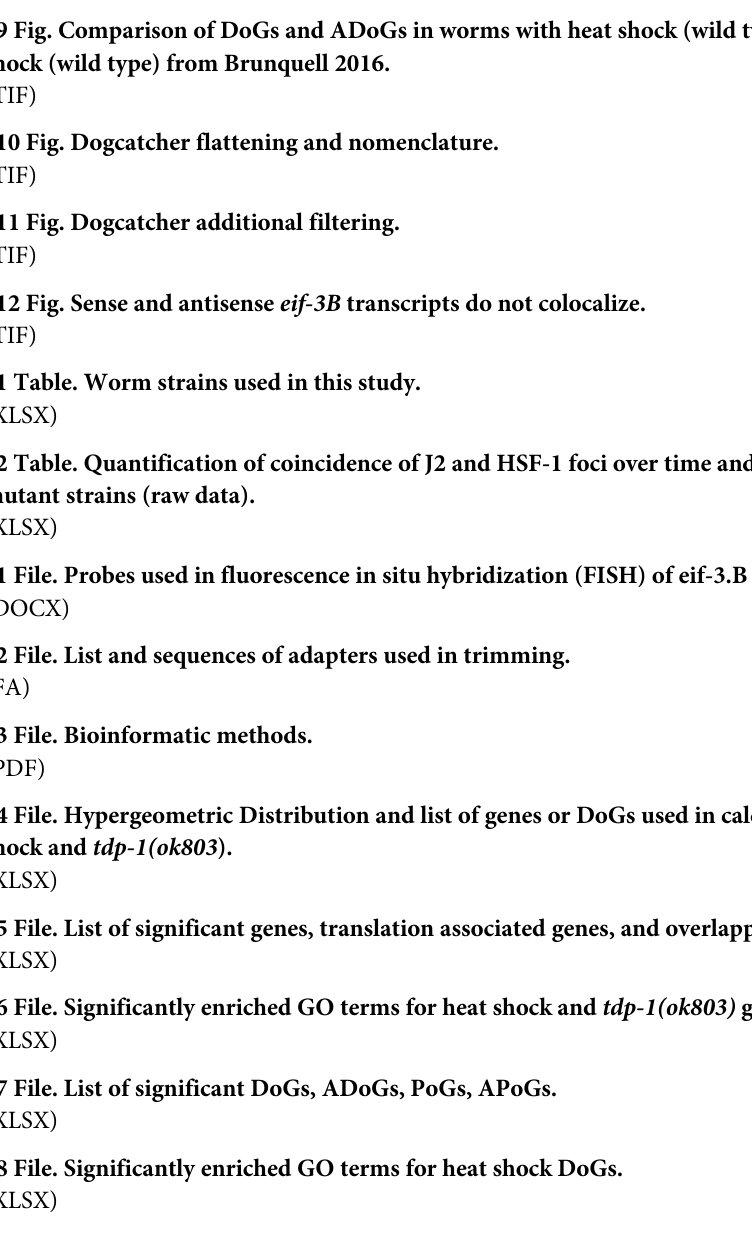
S4 File. Hypergeometric Distribution and list of genes or DoGs used in calculation for heat shock and tdp-1(ok803